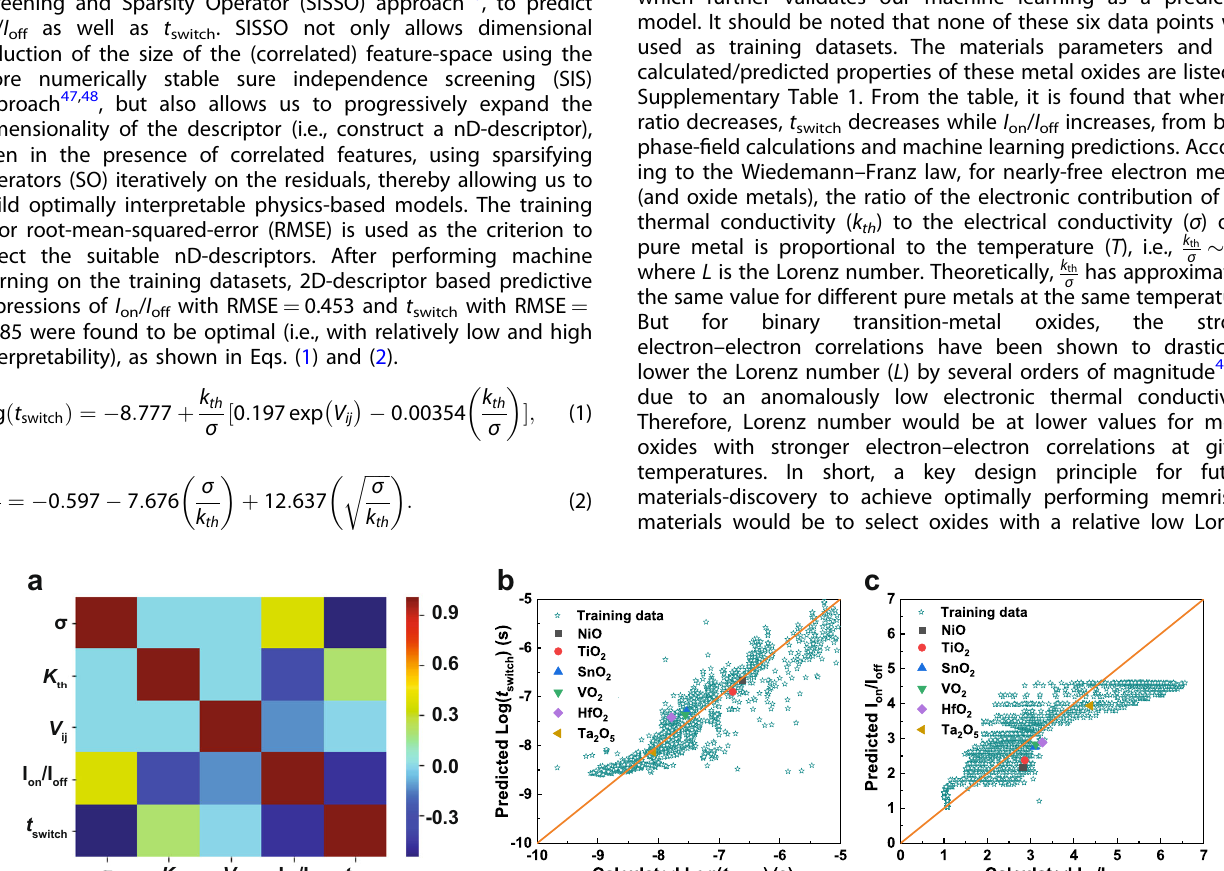
Fig. 4f-h. In addition, several data points marked with colored solid symbols in Fig. 4e represent the metal oxides of VO 2 , Ta 2 O 5 , SnO 2 , NiO, HfO 2 , respectively, which are commonly used as switching layer in metal oxide-based RRAM 1,3 . It shows that the performance of metal oxide-based RRAM employed with these materials are